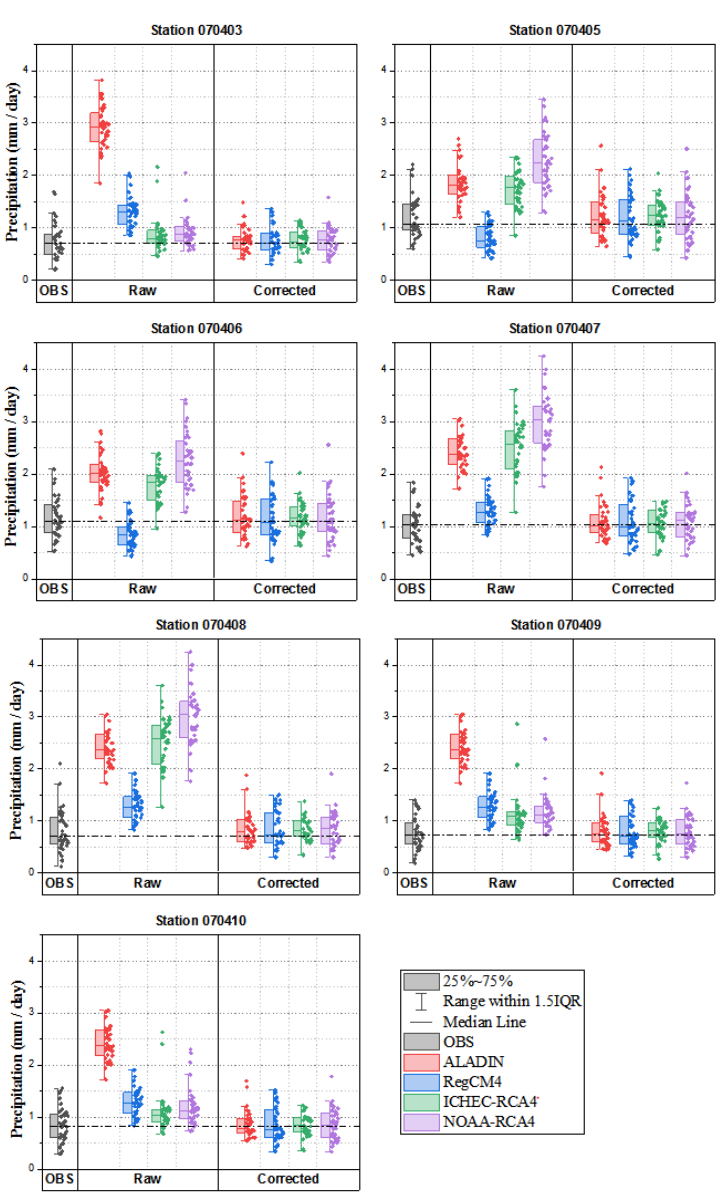
Figure 2. Grouped Half Box–Scatter plot of raw, corrected RCMs and the observational annual cycle of daily precipitation over the historical period (1970 – 2005) for seven rain gauges locations in Wadi Chemora Basin.